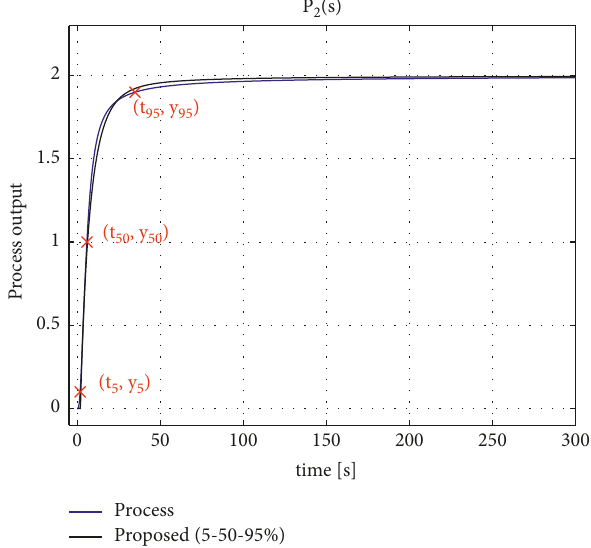
Figure 18: Process reaction curve and FFOPDT model method # 3 (15–50–85%) step response for process P 2